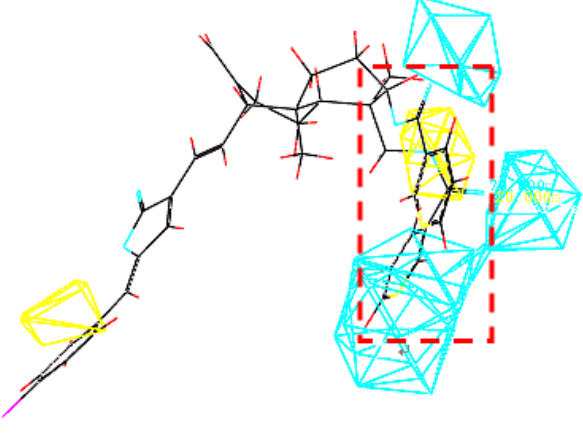
Figure 7. Compound 21 placed in the hydrophobic contour map.